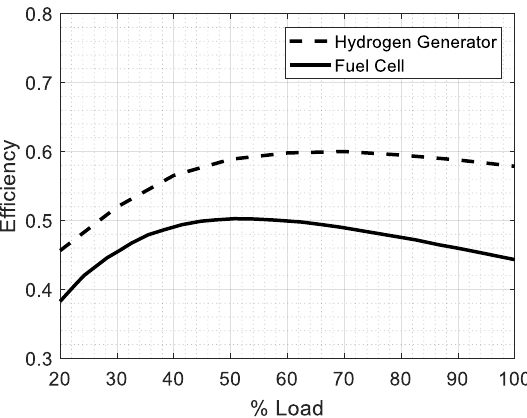
Figure 4. Hydrogen generator and proton exchange membrane (PEM) fuel cell efficiency curves.